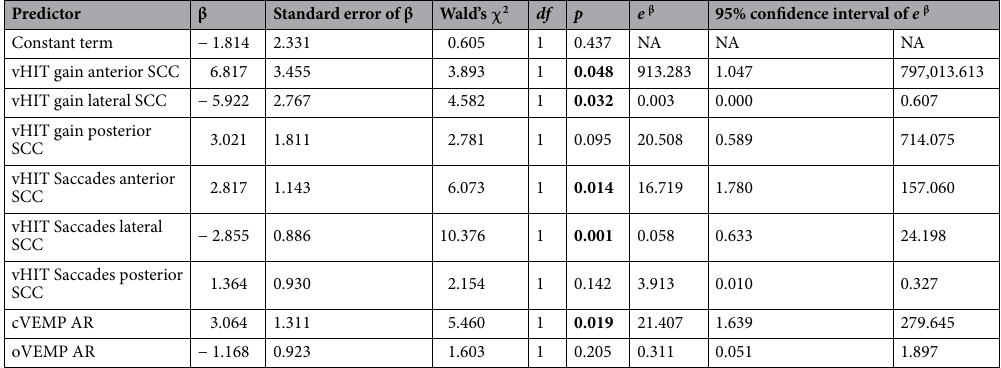
Table 4. Logistic regression analysis of superior nerve of origin prediction. AR asymmetry ratio, cVEMP cervical vestibular evoked potentials, NA not applicable, oVEMP ocular vestibular evoked potentials, SCC semicircular